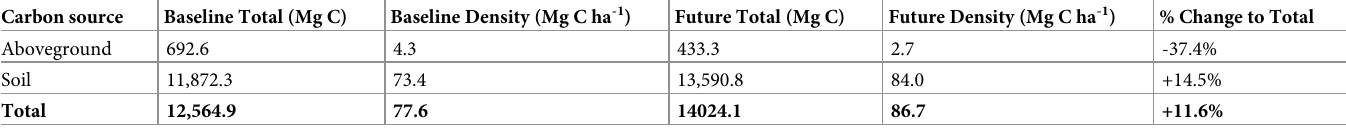
Table 5. Summary of current and projected total